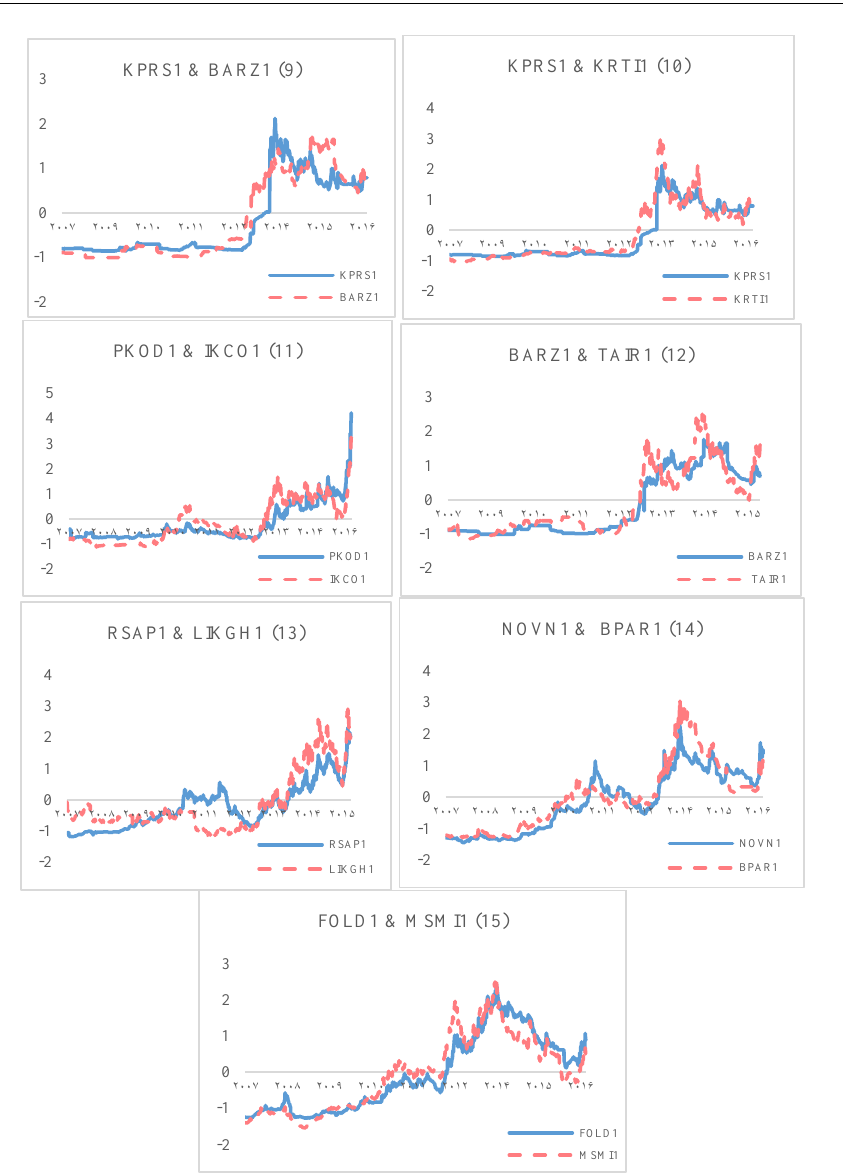
Fig1. Time series plot of normalized prices for selected pairs in the in-sample period